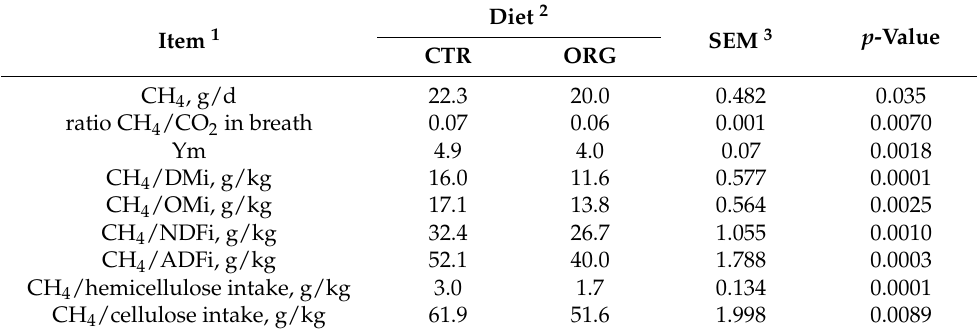
Table 8. Methane emission of Murciano-Granadina dried goats ( n = 10) by the type of